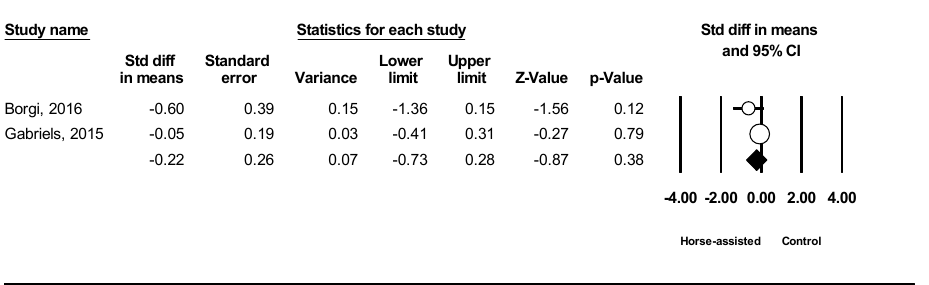
Figure 6. Forest plot showing the effects of horse-assisted therapy vs. control on irritability [12,44].